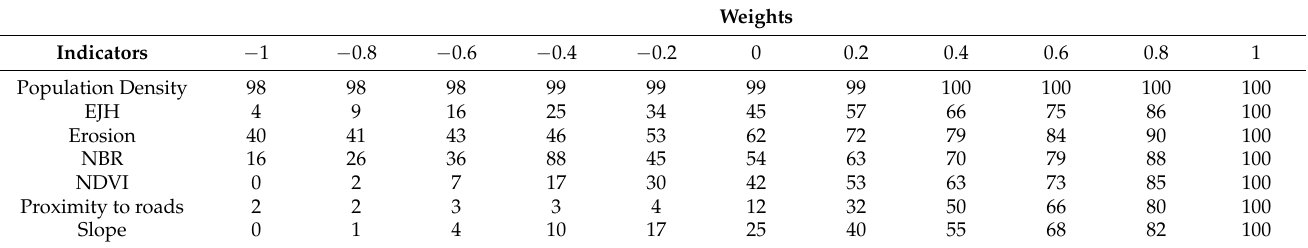
Table 2. Agreement (%) results for changes in weights of each indicator (ranging from − 1 to 1). The analysis corresponds to a comparison from a raster representing a weight change for a specific indicator and the raster representing the baseline